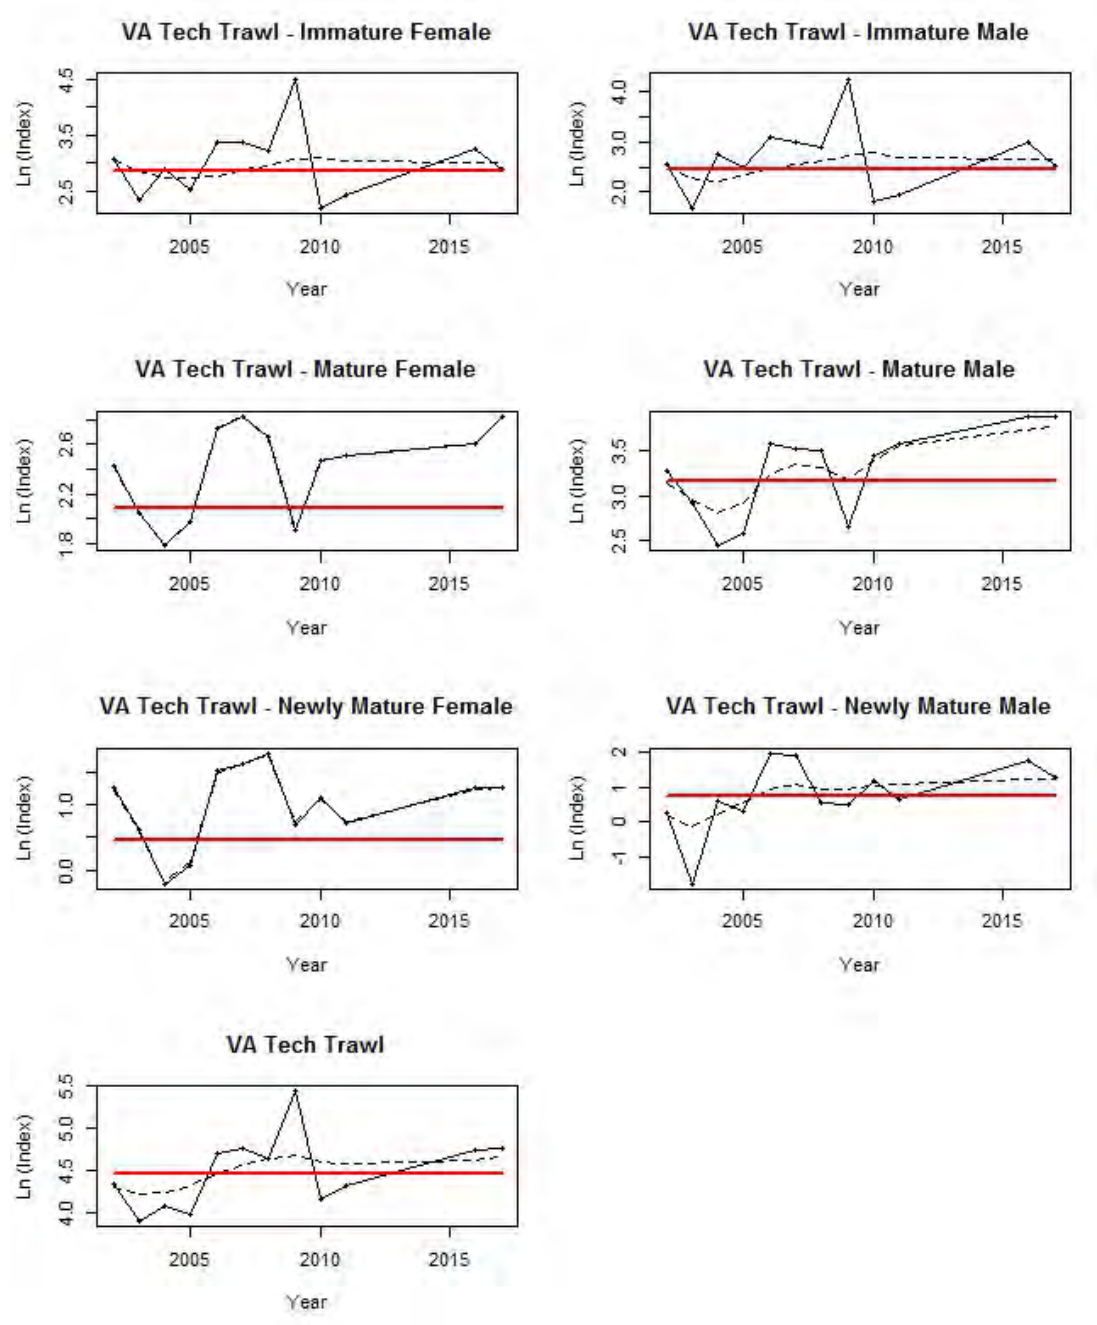
Figure 88. ARIMA model fits to horseshoe crab indices from the VA Tech Trawl survey in the Mid-Atlantic Region. The solid line represents the observed ln transformed indices and the dashed line represents the fitted indices. The red horizontal line represents the Q 25 reference point and the blue horizontal line represents the 1998 reference